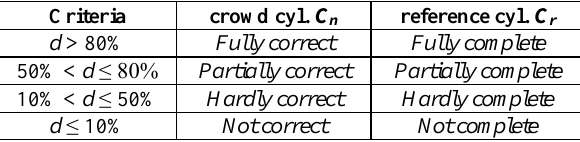
Table 1. Categories of cylinders based on an evaluation of the mutual